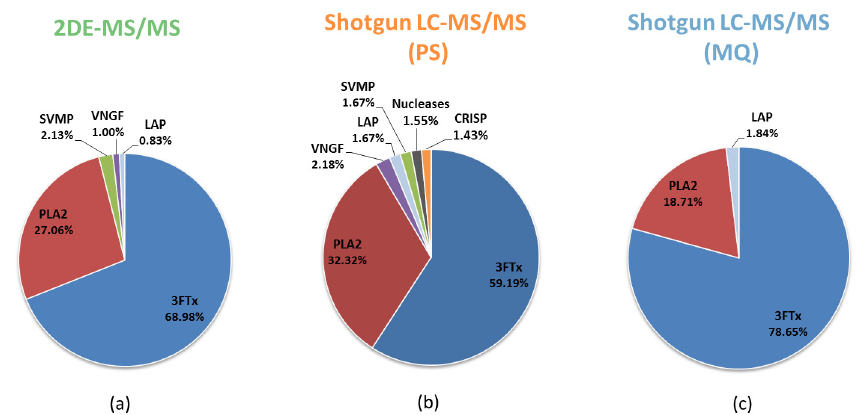
Figure 2. The percentage distribution of different protein families in Naja ashei venom proteome calculated on the basis of different research workflows: ( a ) densitometry after 2DE-MS/MS analysis; ( b ) Shotgun LC-MS/MS proteomics processed by PeptideShaker; ( c ) Shotgun LC-MS/MS proteomics processed by MaxQuant; LAP (Low abundant proteins)—proteins whose total percentage share did not exceed 1% were included in the LAP group. The complete list of proteins with its quantitative data is provided in Table S1.